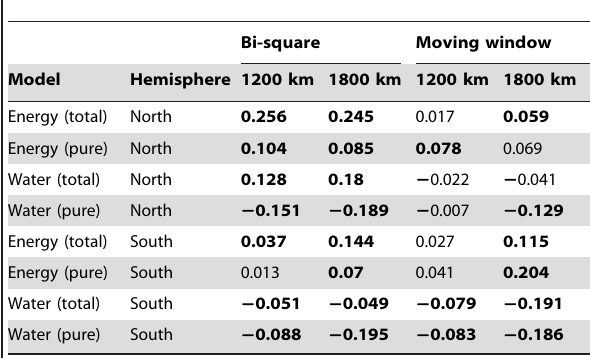
Table 2. Latitudinal trends in the amount of variation in American palm species richness locally explained by water and energy